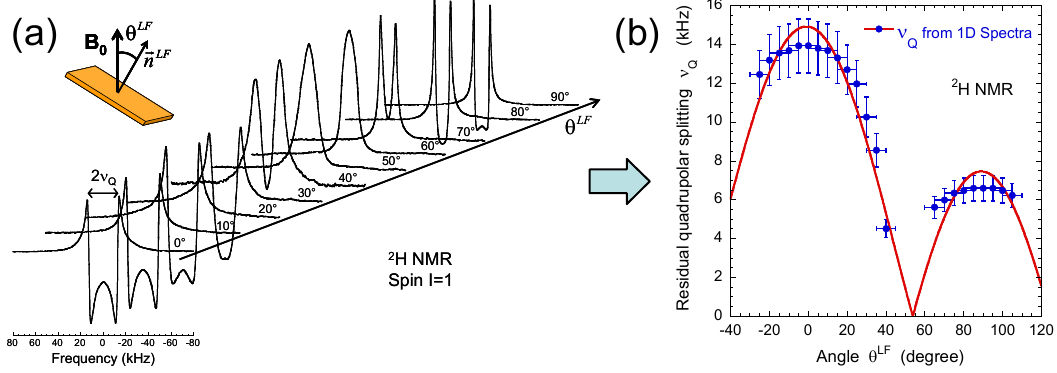
Figure 4. ( a ) 2 H NMR spectra as a function of the film orientation θ LF into the static magnetic field B 0 ; ( b ) variation of the residual quadrupolar coupling ν Q extracted from the 2 H NMR spectra as a function of the film orientation θ LF into the static magnetic field B 0 . Reprinted with permission from [53]. Copyright (2014) American Chemical